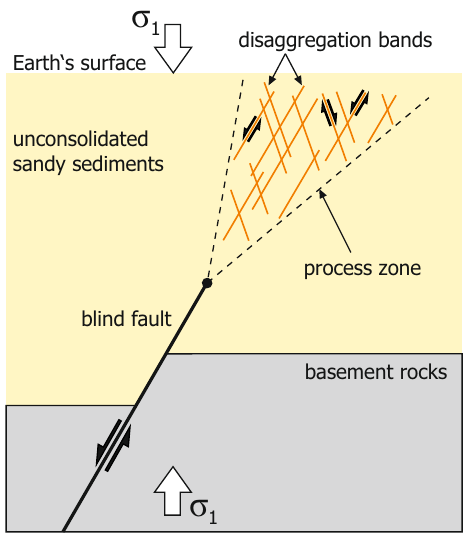
Fig. 7 Conceptual model for the disaggregation band formation, based on 47 . The bands develop in the process zone of a blind fault. For this reason, they are a suitable indicator of paleo-fault activity, even if the fault does not reach the Earth ’ s